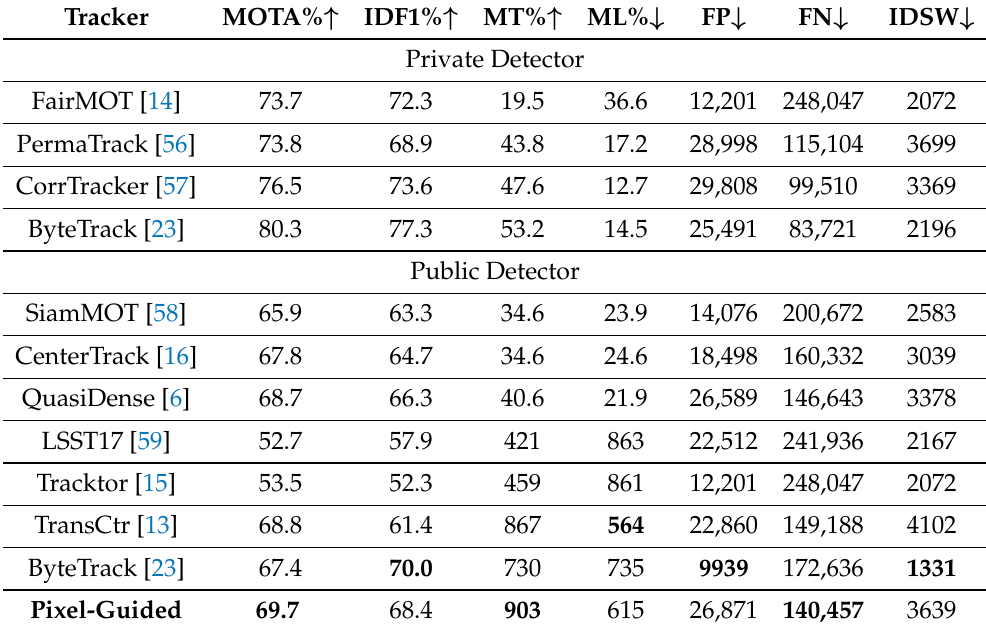
Table 3. Performance of our tracker on the MOT17 benchmark. Our proposed approach is in bold text.